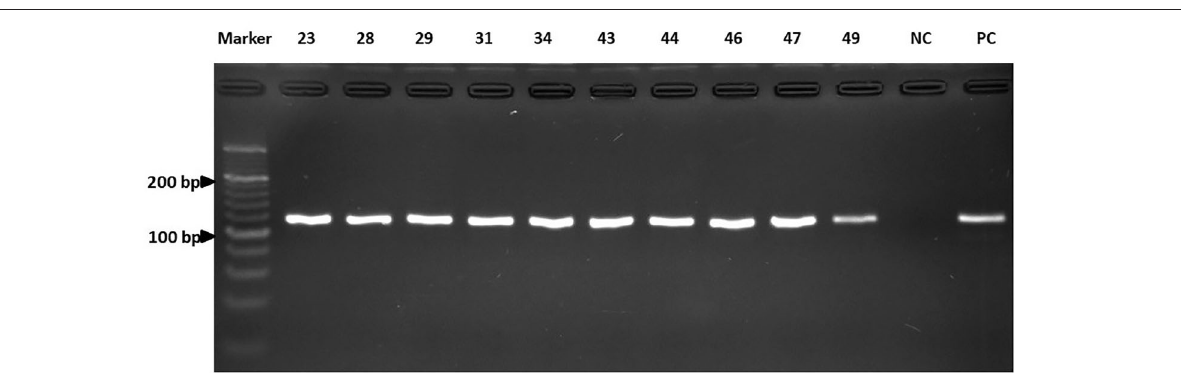
FIGURE 2 | The results of the real-time PCR assay. Detection of the nuc gene of S. pseudintermedius by electrophoresis. Line A: Marker. Lines B to K: Isolates. NC, Negative control; PC, Positive control. Electrophoresis was run as indicated in Materials and Methods.